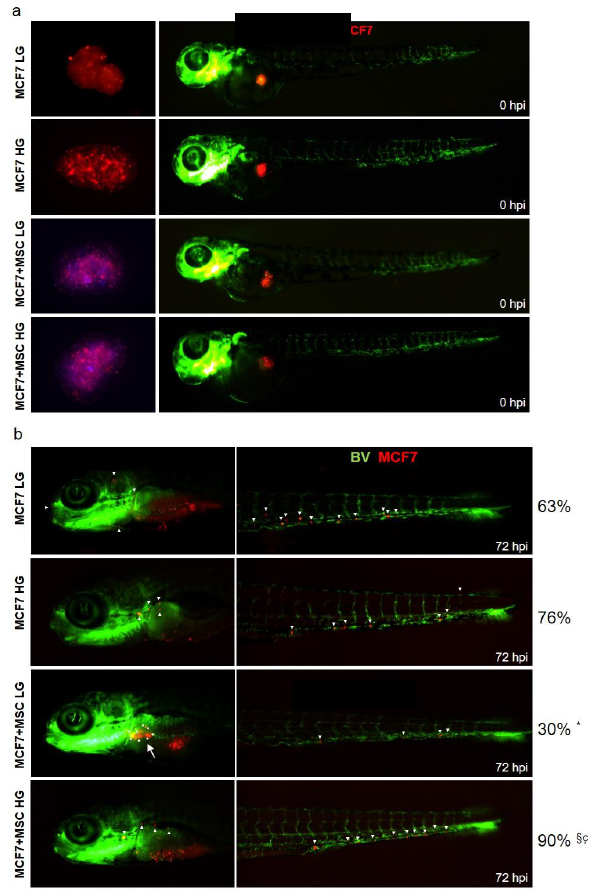
Figure 8. Effect of glucose on MCF7-MAT-MSCs organoids in xenograft zebrafish models.